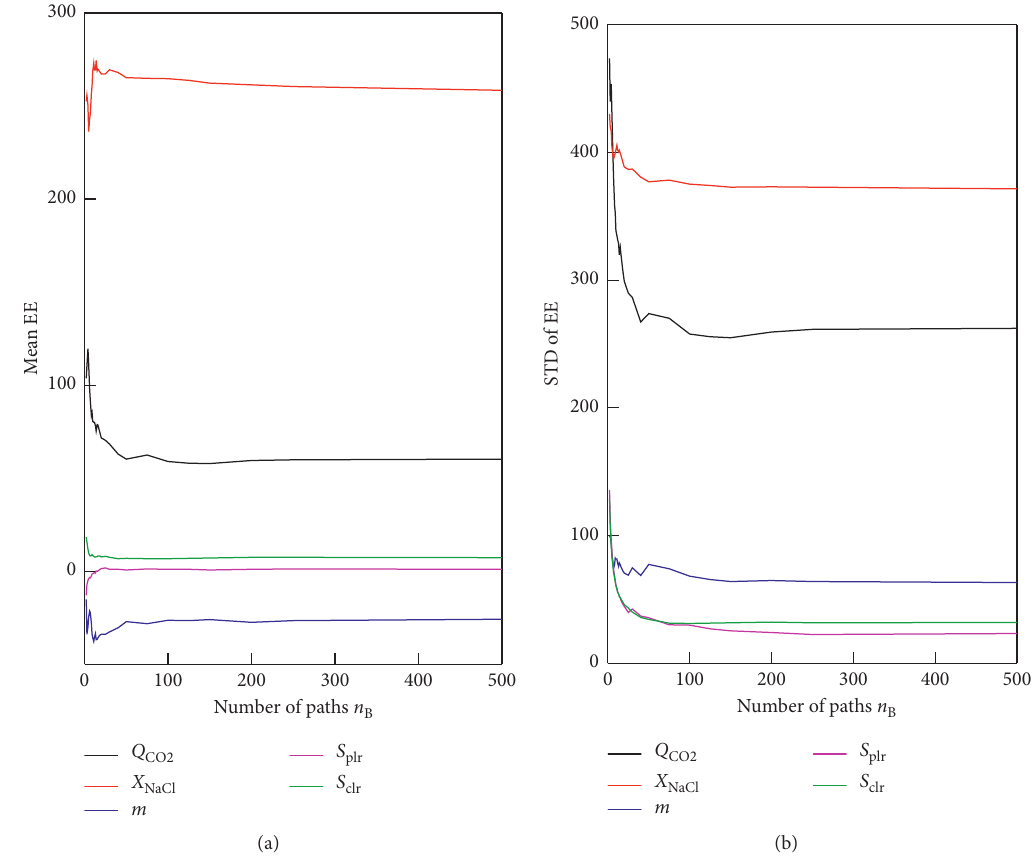
Figure 4: (a) Mean EE and (b) STD of EE as a function of the path ( n